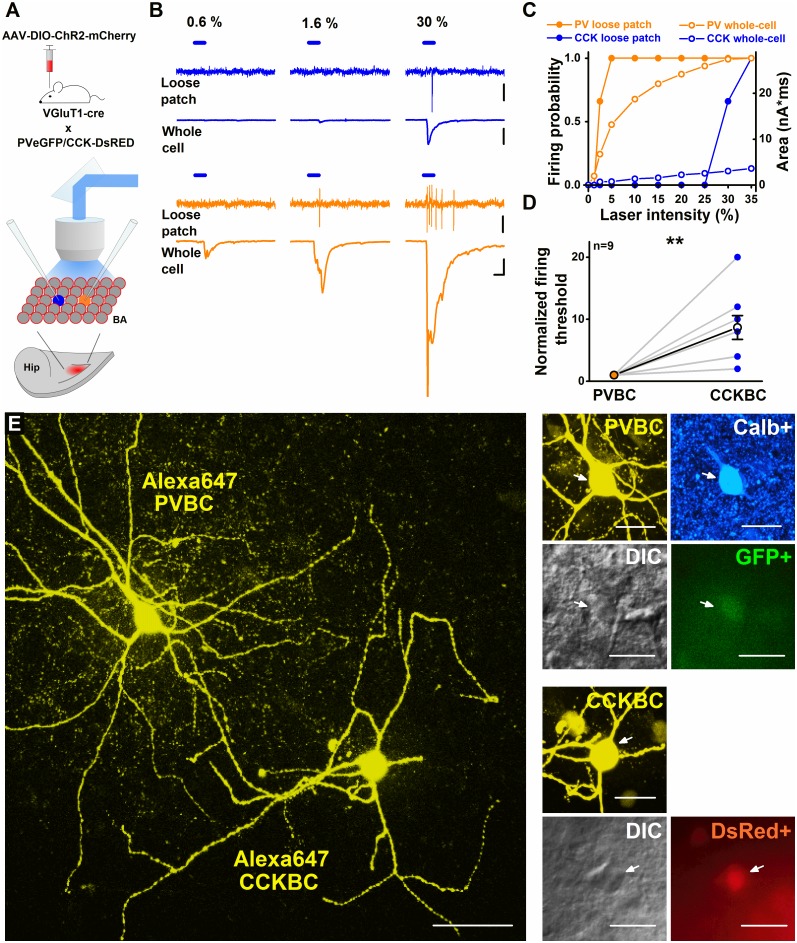
Spiking of parvalbumin-containing basket cells (PVBCs) requires a lower activity level of principal neuron (PN) population than cholecystokinin-expressing basket cells (CCKBCs).(A) Experimental design. mCherry-containing construct was injected into the basal amygdala (BA) of triple transgenic mice (bottom drawing illustrates a horizontal slice showing the expression site in red; Hip, hippocampus; BA, basal amygdala). Among adeno-associated virus (AAV)-infected PNs (red circles), a CCKBC (blue) and a PVBC (orange) were simultaneously recorded first in loose-patch mode, followed by recordings in whole-cell mode, while neighboring PNs were excited by light illumination. (B) Representative traces of loose-patch and whole-cell recordings show different spiking thresholds and, concomitantly, larger light-evoked responses in a PVBC (lower traces) compared to a CCKBC (upper traces) in response to PN stimulation at different light intensities. Averages calculated from 3 consecutive events are shown in blue and orange for the CCKBC and the PVBC, respectively. Scales: y: 25 pA, loose-patch; y: 200 pA whole-cell; x: 10 ms. (C) A summary graph of the experiment shown in (B); the firing probability (solid circles, left axis) and the integral of the light-evoked responses (open circles, right axis) detected in basket cells (BCs) upon gradually elevated stimulation intensities (S8 Data). (D) The activation threshold of PVBCs is significantly lower than that recorded simultaneously in CCKBCs. Firing threshold values are normalized to PVBC firing threshold (CCKBC: 8.67 ± 1.91, n = 9 dual recordings; Paired Sample Wilcoxon Signed Rank Test, p < 0.01) (S8 Data). (E) Maximum z intensity projection image of the in vitro biocytin-filled interneurons from which data are shown in (B) and (C). Right, images illustrate the presence of calbindin (Calb+) immunopositivity in the PVBC (blue), while epifluorescent images show the expression of enhanced green fluorescent protein (eGFP) in the PVBC and red fluorescent protein (DsRed) in the CCKBC together with the corresponding differential interference contrast images. Scales: 50 μm, insets: 25 μm.